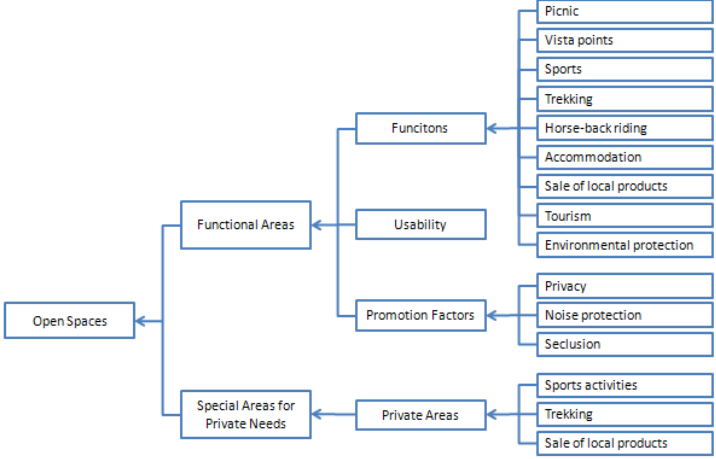
Figure 3. The goal hierarchy for VBA of the BLANP opens